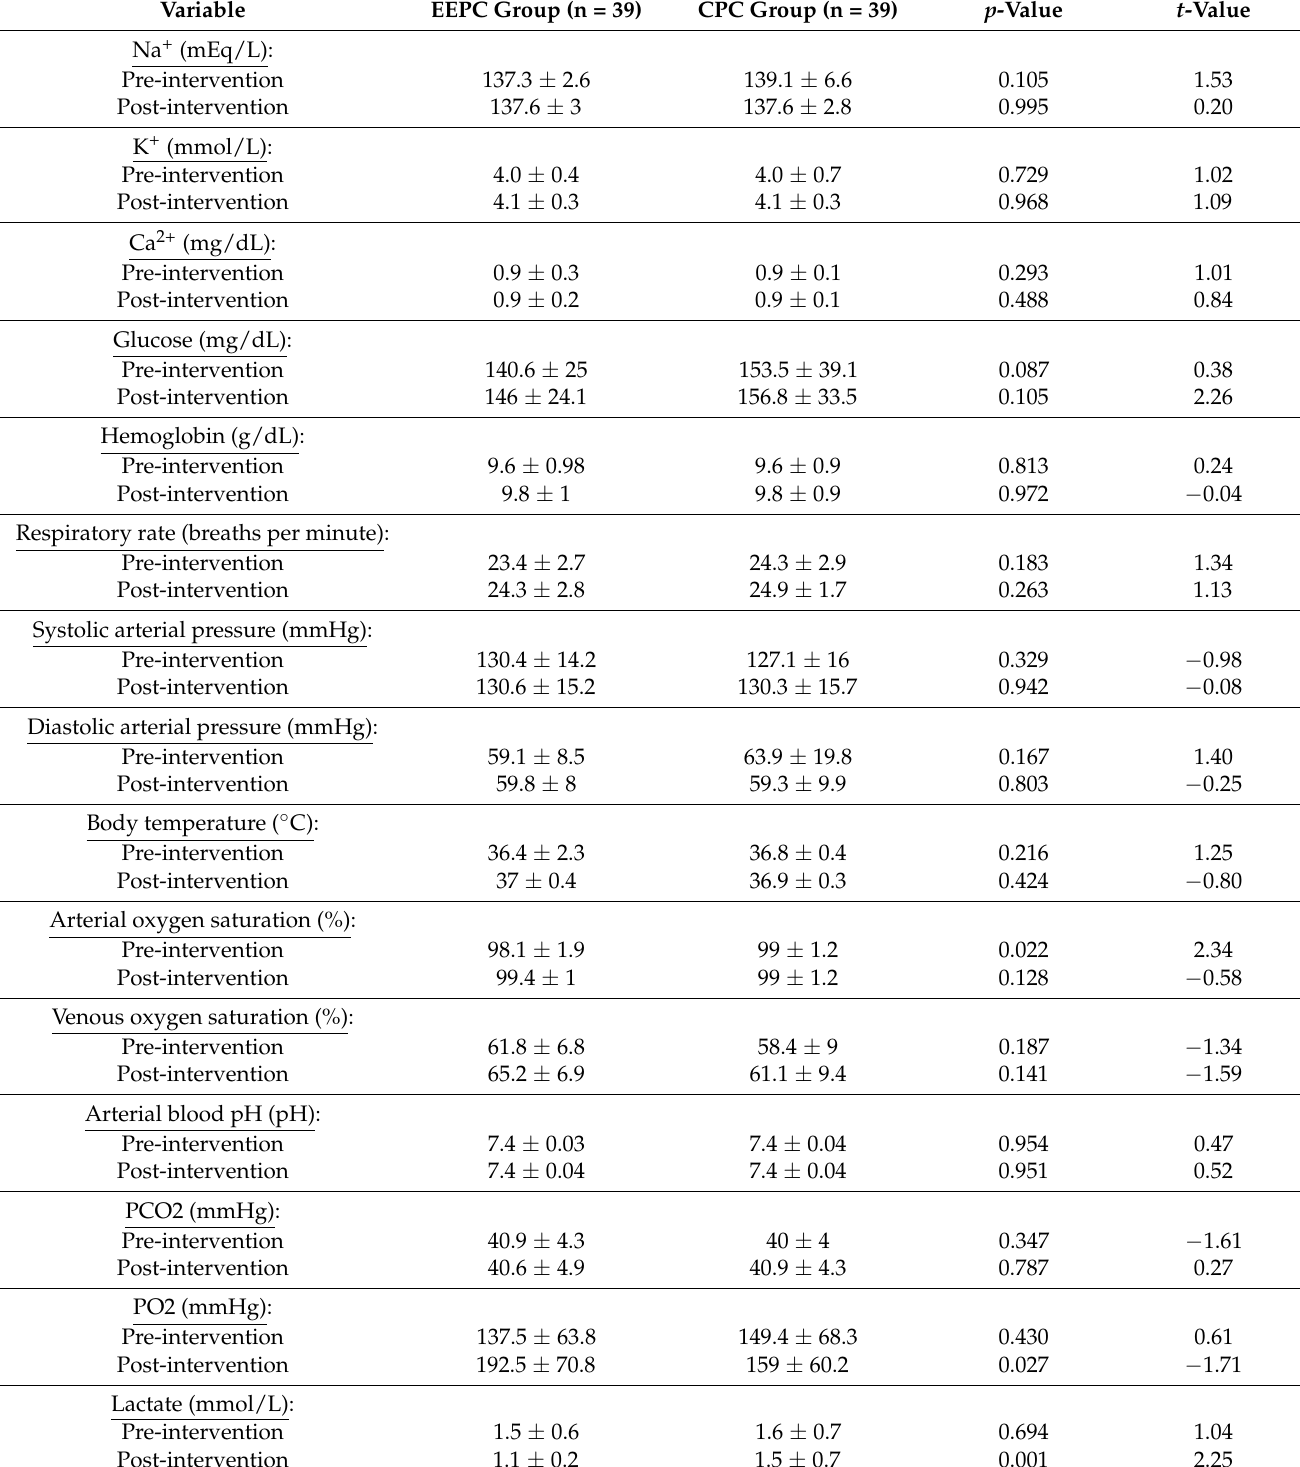
Table 2. Comparison of pre- and post-intervention laboratory, oxymetric and hemodynamic measurements. Variable EEPC Group (n = 39) CPC Group (n = 39) p -Value t -Value Na + (mEq/L): 137.3 ± 2.6